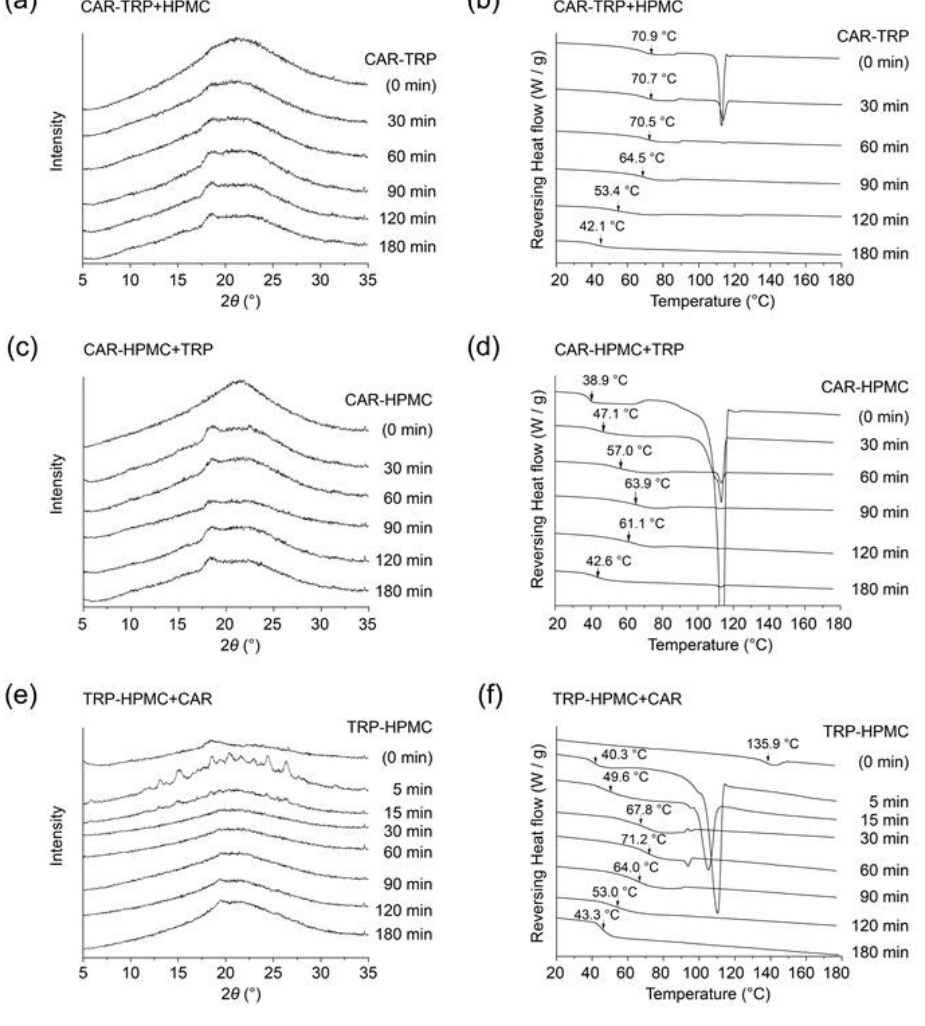
Figure 2. XRPD diffractograms and DSC thermograms of ball milled CAR − TRP + HPMC ( a , b ), CAR − HPMC + TRP ( c , d ) and TRP − HPMC + CAR ( e , f ) A − B + C amorphous systems. The T g s are indicated by arrows. The end point of ball milling of the “A − B” system is taken as the starting point of the milling of the “A − B + C” system.